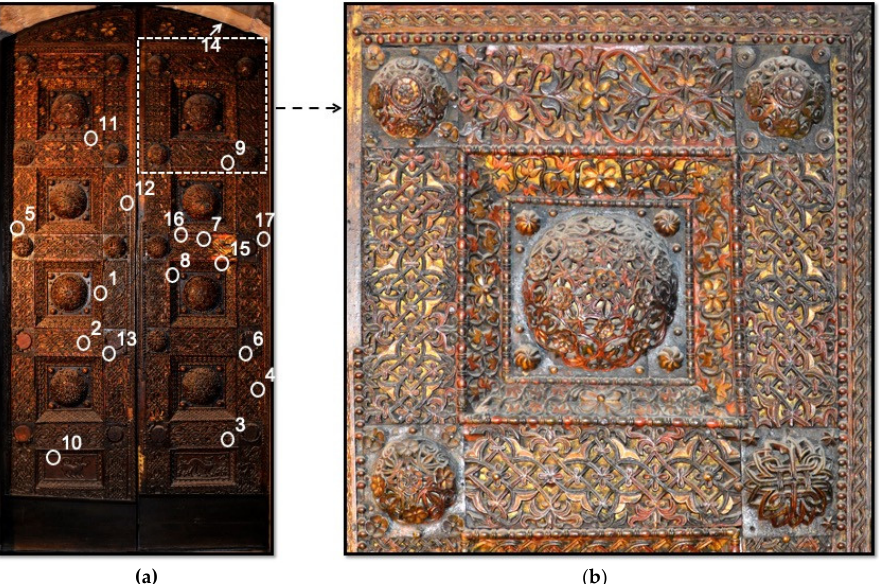
Figure 1. ( a ) Sampling spots and ( b ) detail from the decorated wood-carved door of the Church of Dionysiou Monastery in Mount Athos. Dimensions of each door leaf: 240 cm × 60 cm.